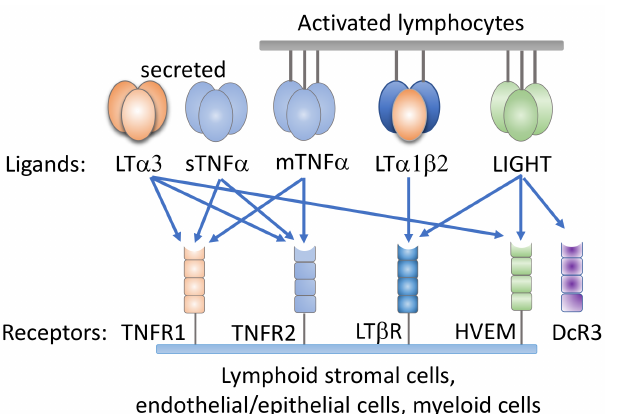
Figure 1. Ligands and receptors of the tumor necrosis factor (TNF)/lymphotoxin system. Both heterotrimeric LT α 1/ β 2 and homotrimeric LIGHT bind to LT β R. Herpes virus entry mediator (HVEM) binds to membrane LIGHT and soluble homotrimeric LT α 3. Membrane TNF α (mTNF α ), soluble TNF α (sTNF α ), and LT α 3 bind to TNFRI and TNFR